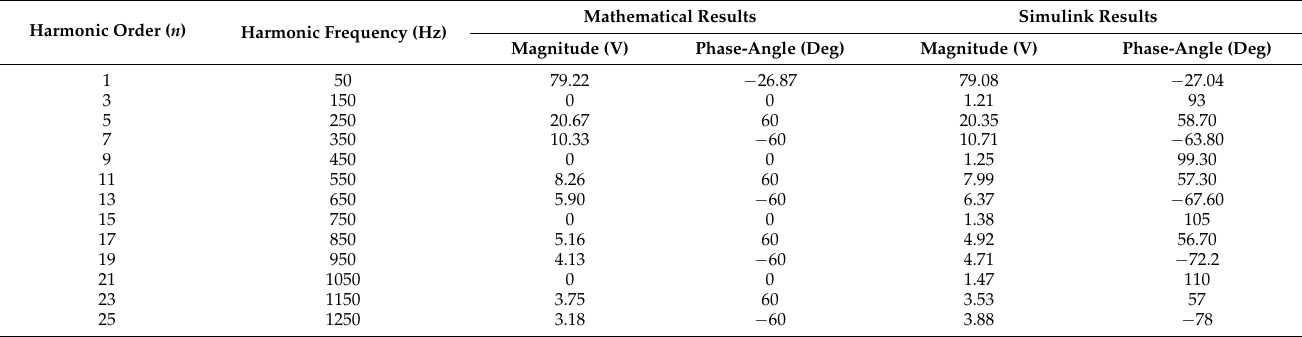
Table 7. Harmonic coefficients of one phase of a three-phase AC voltage controller with a 90 ◦ firing delay without wave